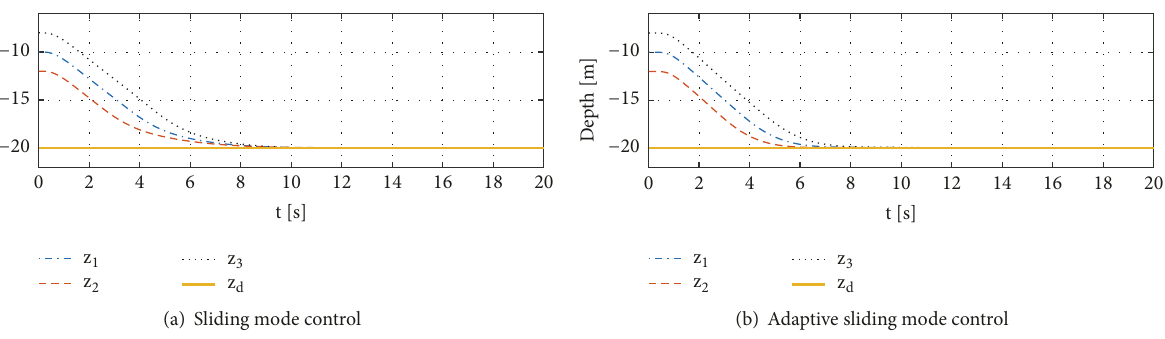
Figure 4: The depth evolving of each AUV.